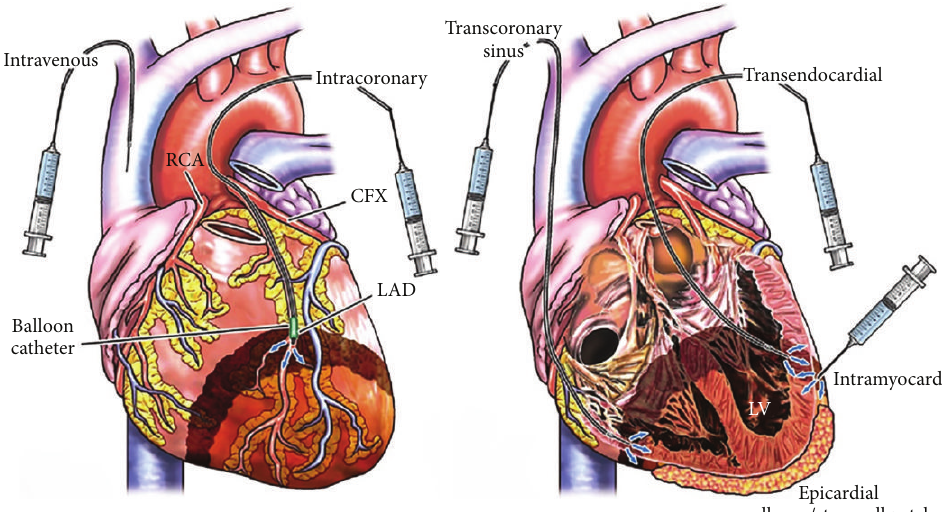
Figure 3: Schematic of stem cell delivery methods for various SCT applications: in cardiac repair, stem cells are either delivered through the vena cava or coronary artery for intracoronary application. Transcoronary sinus or transendocardial or direct injection is used for intramyocardial applications. Reproduced courtesy of Elsevier Publishing group